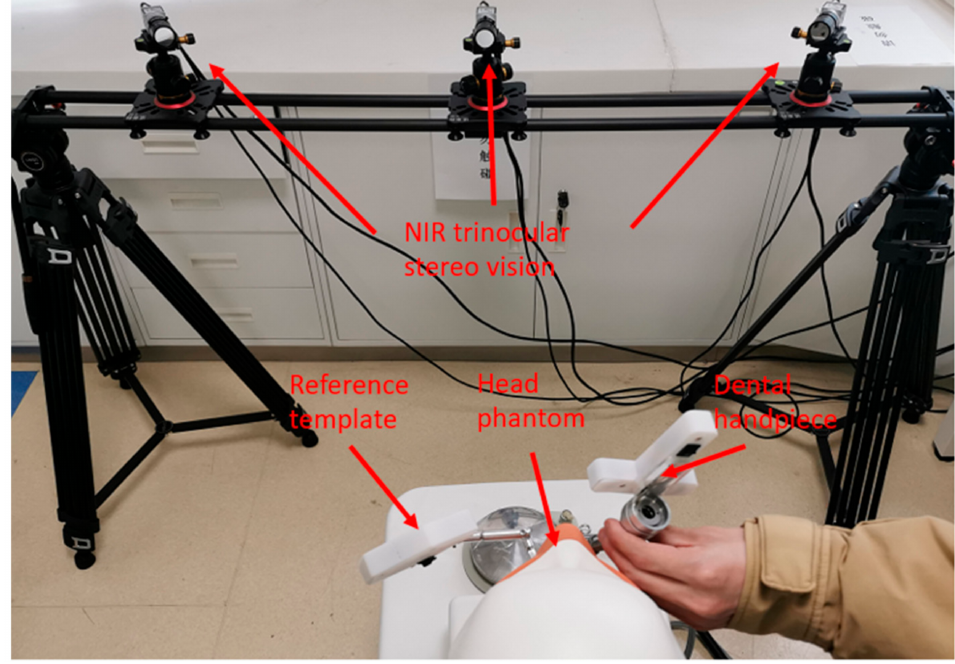
Figure 8. System